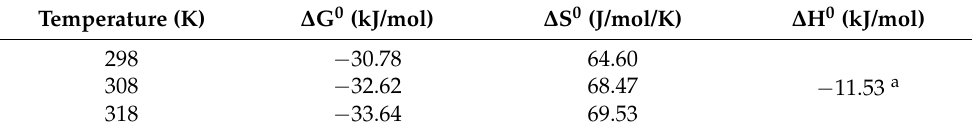
Table 2. Thermodynamic parameters for RhB adsorption by BOI 2 /BMO. Temperature